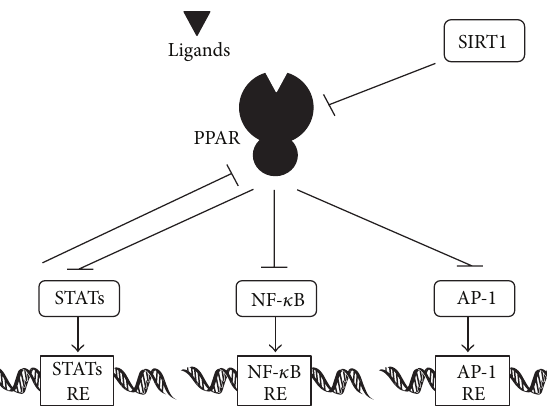
PPAR regulatory network. Examples of molecules known to interact with PPARs pathway in mammals are shown. Hammerheads mean inhibition. Note that some critical pathways have been omitted for